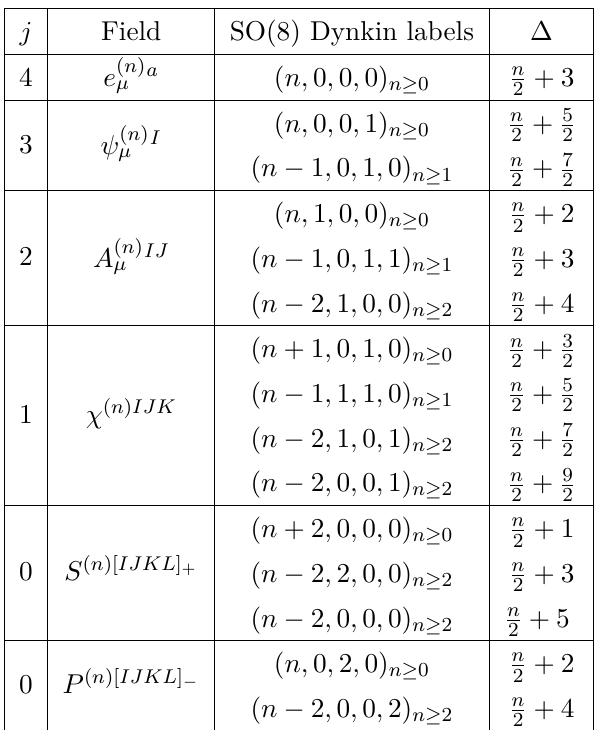
Table 2 . The massive N = 8 supermultiplets B 1 [0] ( n +2 , 0 , 0 , 0) same as in table